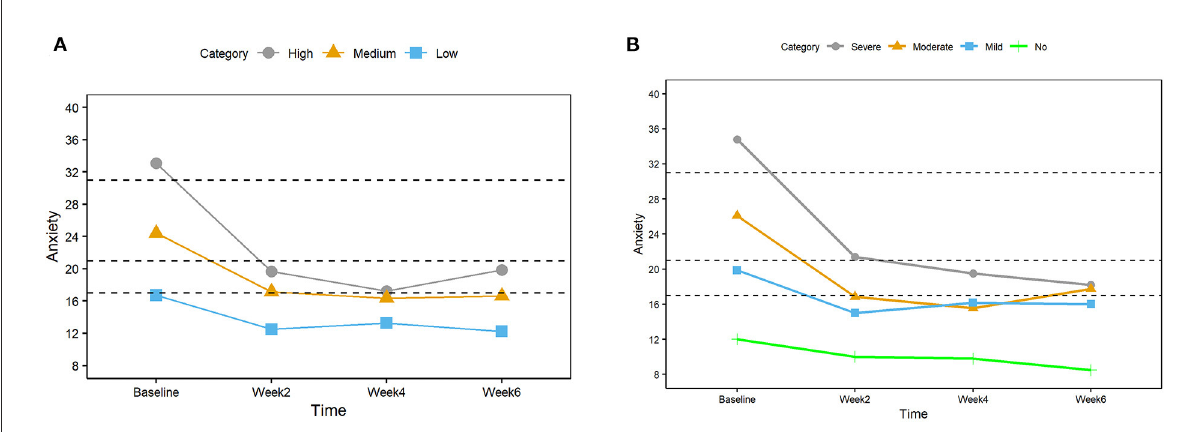
FIGURE3 (A) Mean anxiety scores for three groups (High, Medium, and Low) based on the tertiles at the baseline. The dashed horizontal lines indicate clinically significant cutoffs (17, 21, and 31). (B) Mean anxiety scores for four groups (Severe, Moderate, Mild, and No) based on the clinically significant cutoffs at